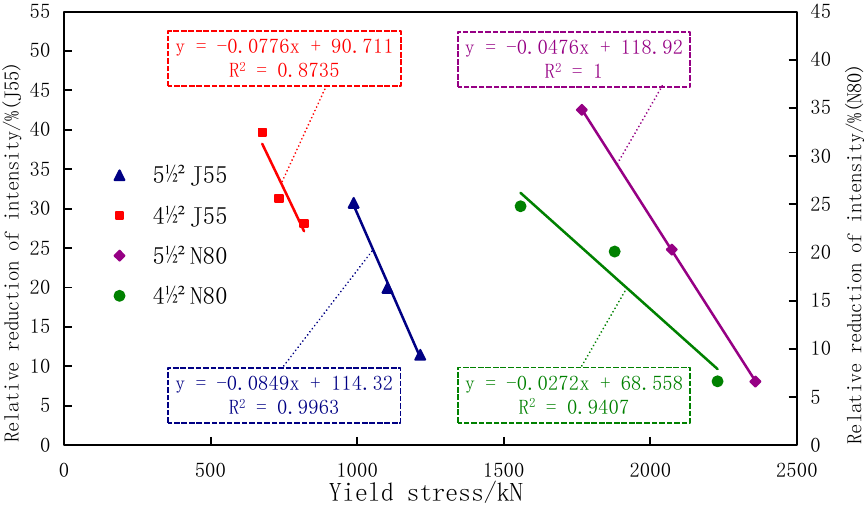
Figure 18. Relationship between relative intensity-reduction ratio and yield stress.